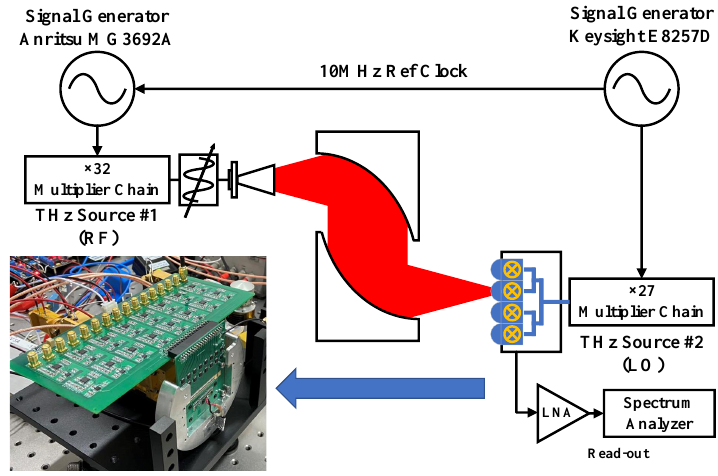
Figure 17. The measurement setup of the designed receiver front-end. Figure 18 shows the measured IF signal and noise at different gate voltages. The RBW is 100 Hz. It can be seen that the IF signal from DET 1 and DET 16 is different from other detectors. The noise level of DET 1 is abnormal. These phenomena indicated that the DET 1 and DET 16 do not work properly, even if their I–V characteristics were normal before assembly. Figure 19 shows the measured SNR and NEP at different gate voltages. By calculating the NEP of TeraLDA, the best NEP is − 92 dBm/Hz with DET 8 at optimal gate voltage of − 3.76 V. The average NEP of the TeraLDA pixels is − 87.6 dBm/Hz. The LO power from × 27 multiplier chain is 1.2 mW. According to the above power divider measurement results, the LO power on the power divider output port is about − 13.75 dBm.